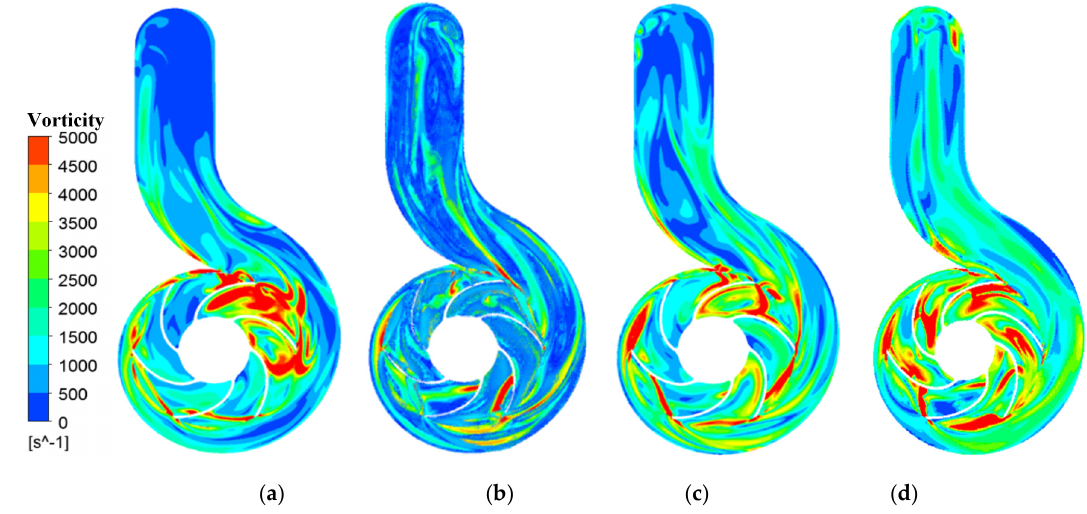
Figure 14. Vortex distribution of model pump: ( a ) 0.5 Q r , ( b ) 0.7 Q r , ( c ) 1.0 Q r , ( d ) 1.2 Q r .